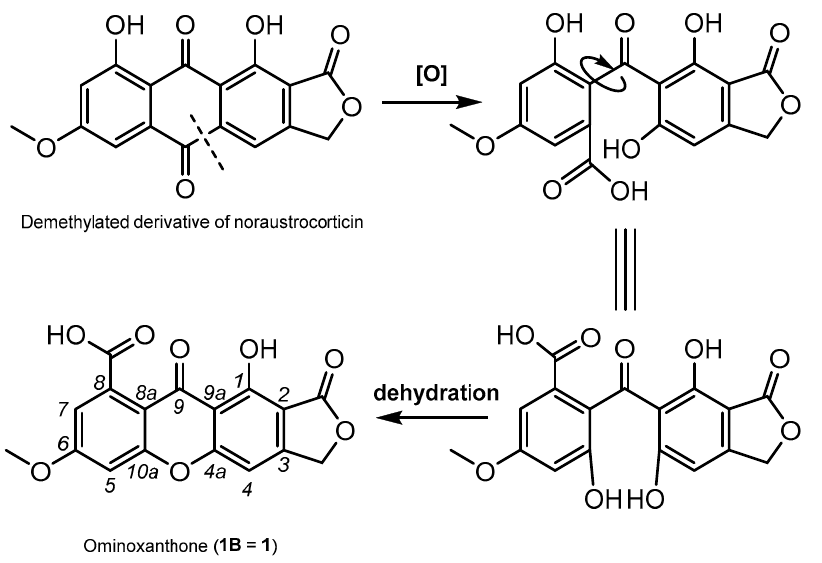
Figure 7. Plausible biosynthetic pathway for ominoxanthone ( 1B ) .